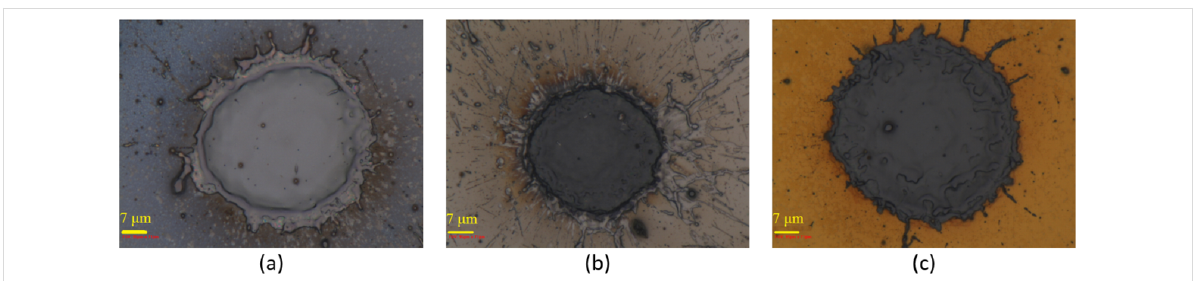
Figure 8: (a) Isolated pulse on the surface of silicon, (b) Isolated pulse on the surface of silicon coated by aluminum thin film, (c) Isolated pulse on the surface of silicon coated by gold thin